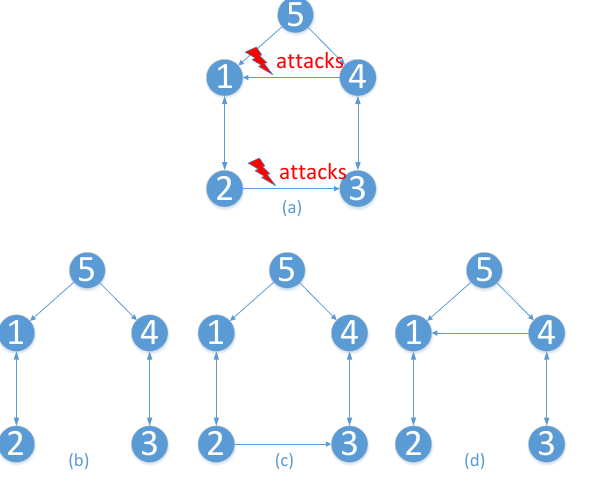
Figure 7. Switching topologies.